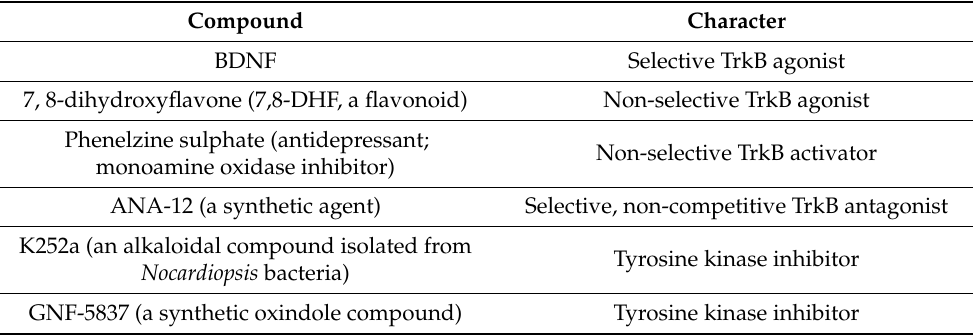
Table 1. Modulators of TrkB receptor signalling tested in this study. Compound Character BDNF Selective TrkB agonist 7, 8-dihydroxyflavone (7,8-DHF, a flavonoid) Non-selective TrkB agonist Phenelzine sulphate (antidepressant; Non-selective TrkB activator monoamine oxidase inhibitor) ANA-12 (a synthetic agent) Selective, non-competitive TrkB antagonist K252a (an alkaloidal compound isolated from Tyrosine kinase inhibitor Nocardiopsis bacteria) GNF-5837 (a synthetic oxindole compound) Tyrosine kinase